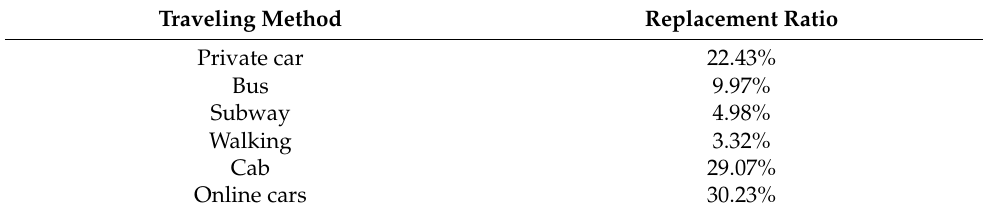
Table 6. Substitution ratios for the different modes of travel.